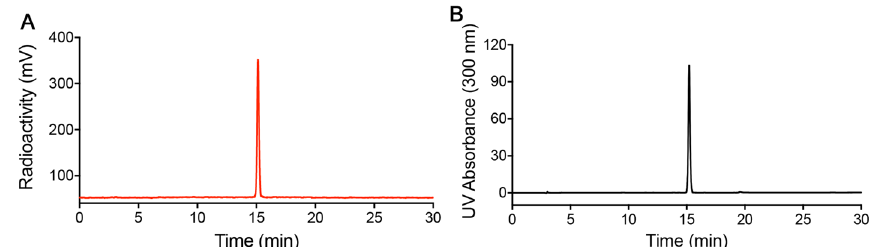
Fig. 4 HPLC traces of [ 18 F]FBNA (left) ([ 18 F]FBNA: t R . (FBNA: t R . 15.0 0.3 min). UV detector was installed ahead of radioactivity = ±